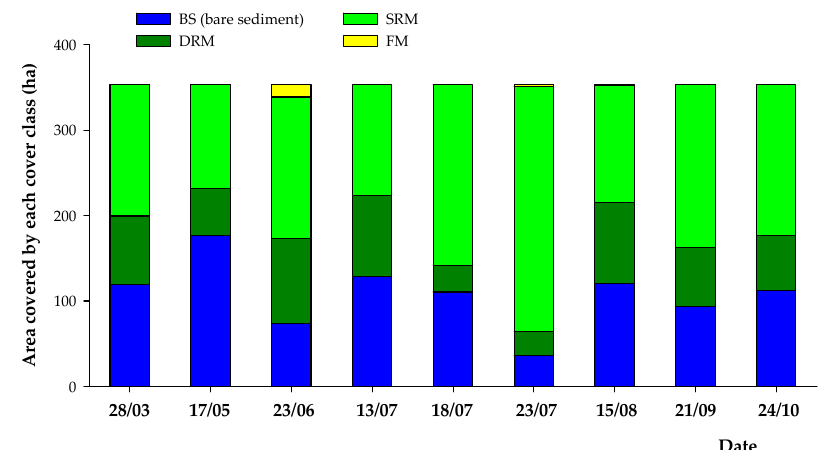
Figure 5. Cover trends (expressed in ha) of the three bottom cover classes (BS, DRM, and SRM) and of the area covered by the floating macrophytes (FM) during the 2017 growing season (from late March to late October).